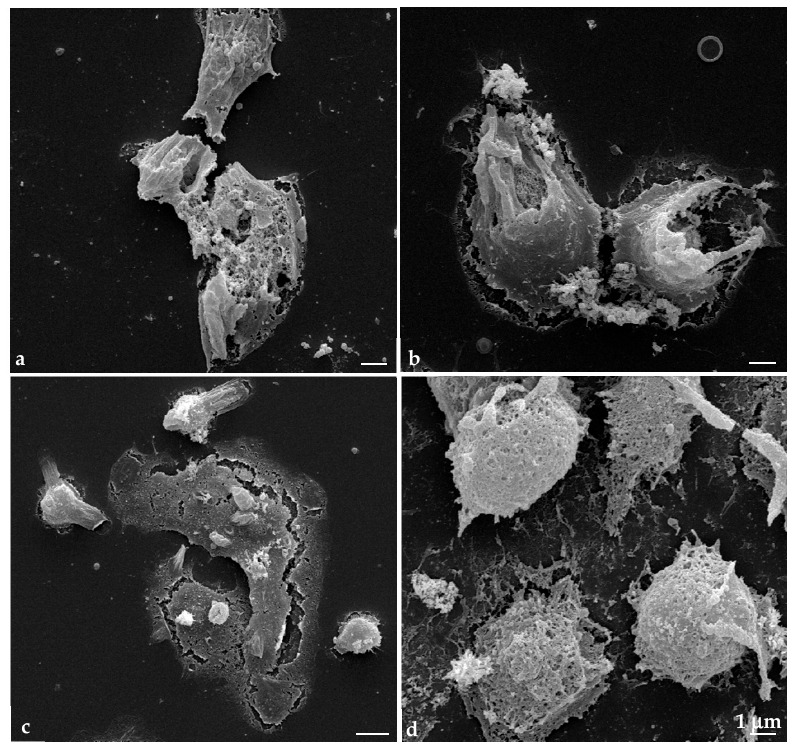
Figure 7. SEM micrographs of SKBR3 cells after 24 h of V. macrophylla EO incubation (0.01 ( a ), 0.1 ( b ), 1.25 ( c ) and 2.5 ( d ) μ g/mL, respectively) .